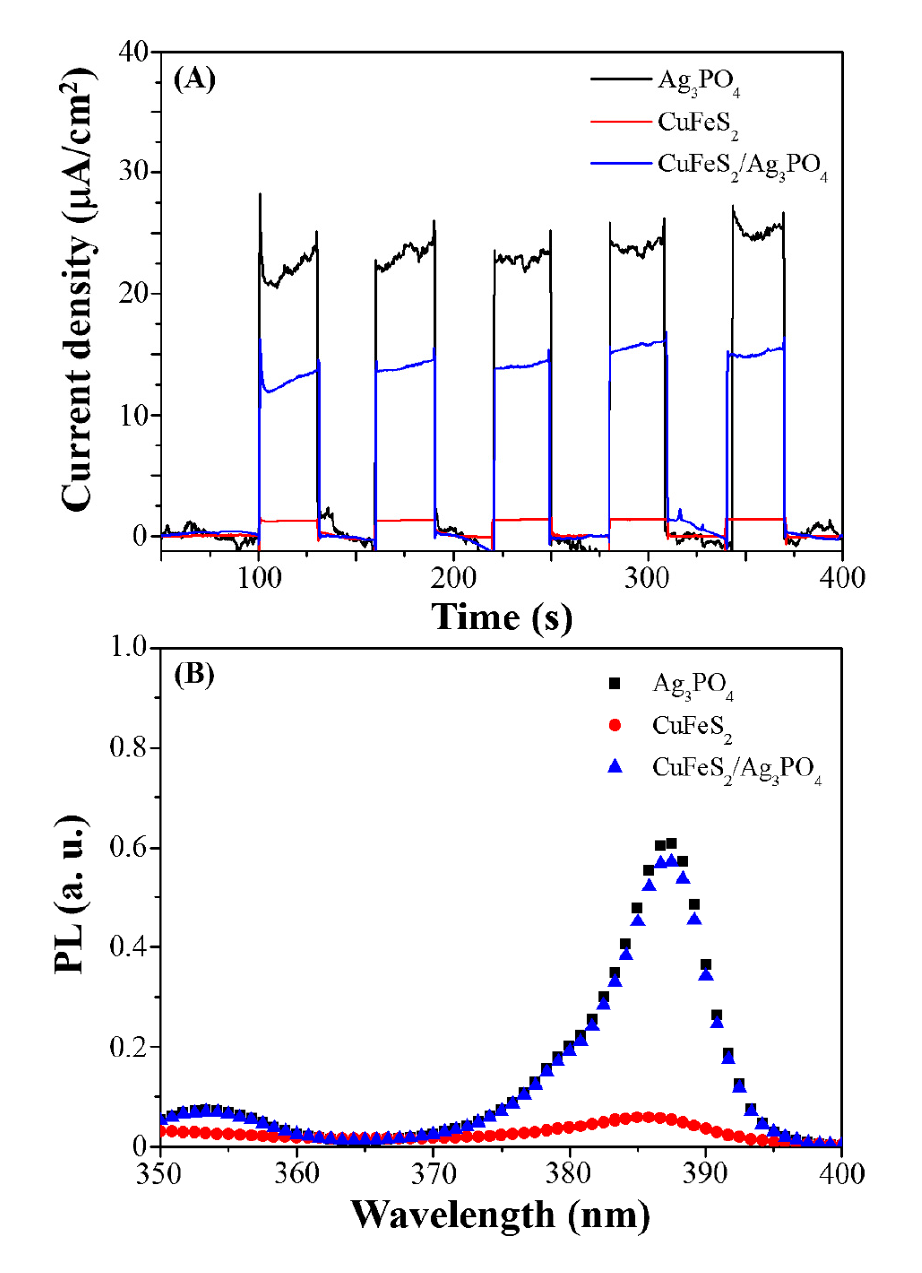
Figure 13. ( A ) Photocurrent density and ( B ) the photoluminescence (PL) spectra of different samples: Ag 3 PO 4 (black), CuFeS 2 (red), and CuFeS 2 /Ag 3 PO 4 composites (blue).